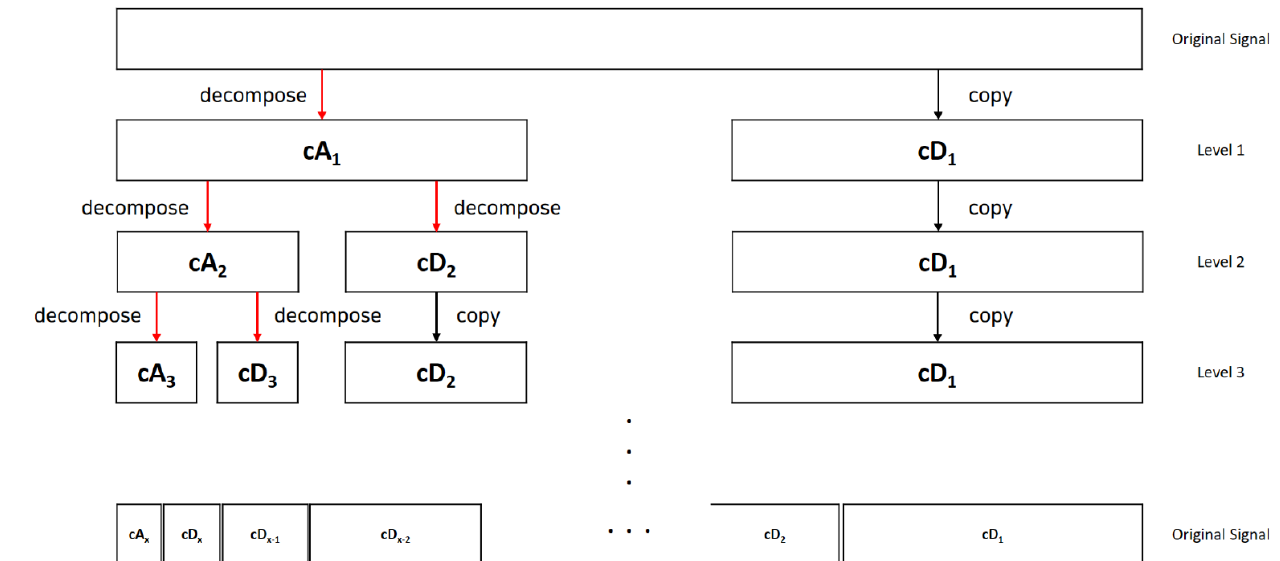
Figure 1. Illustration of the 𝑥 level decomposition process.